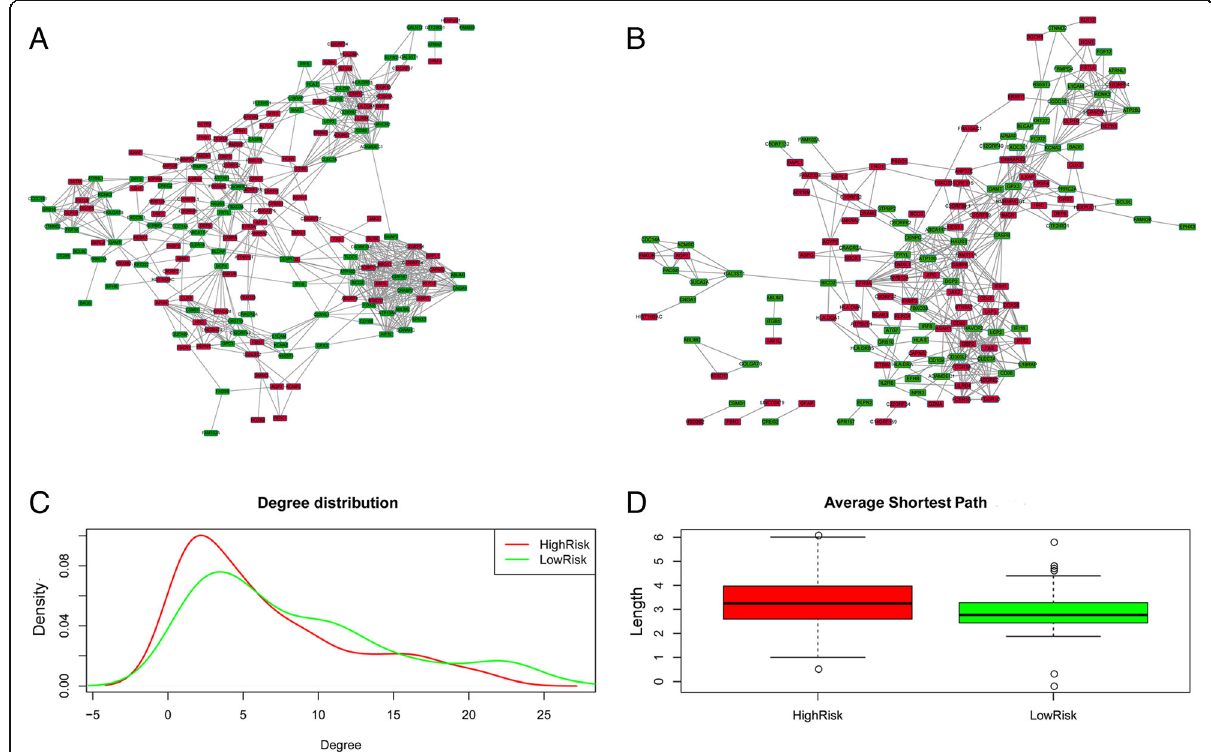
Fig. 2 Co-expression networks for low-risk group ( a ) and high-risk group ( b ), and their topological properties, including degree distribution ( c ) and the average shortest path length ( d ). Red nodes indicate up-regulated genes, whereas green nodes indicate down-regulated